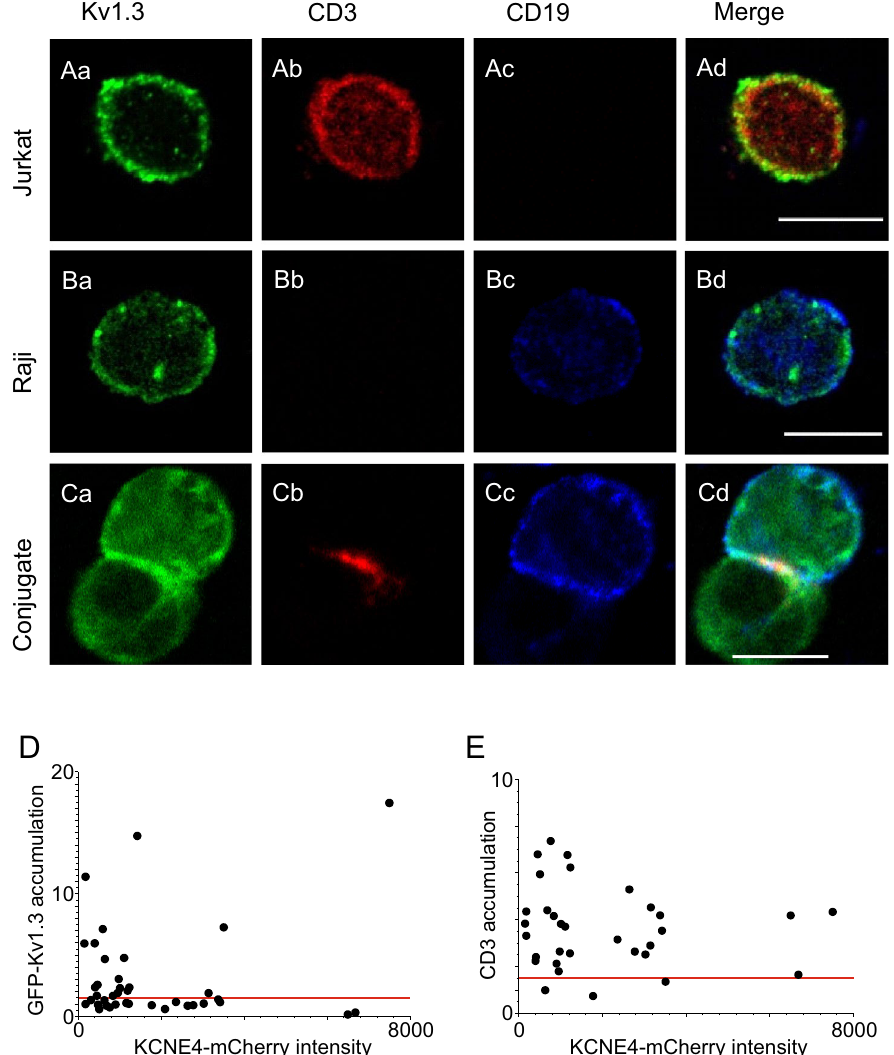
Figure 4. KCNE4 impaired Kv1.3 accumulation in the IS but did not disrupt IS formation. Human Jurkat T lymphocytes and human Raji B lymphocytes were used to generate cell conjugates. ( A – C ) Activated B-cells (10 µg/mL SEE toxin) were cocultured in the absence ( Ba – Bd ) or presence ( Ca – Cd ) of Jurkat cells, and confocal images were obtained. ( Aa – Ad ) Jurkat T-cells in the absence of B cells. Endogenous Kv1.3 (green), CD3 (marker of T-cells, red), and CD19 (marker of B-cells, blue) were detected. ( Ad , Bd , Cd ) merge panels. Note that triple colocalization (white) in Cd localizes Kv1.3 in the IS, as identified by CD3 staining ( Cb ). Bars are 20 µm. ( D ) Accumulation ratio of mGFP-Kv1.3 at the IS vs. KCNE4-mCherry total intensity (n = 40). ( E ) CD3 recruitment into the IS vs. KCNE4 intensity. The horizontal red line represents the threshold level (1.5) for Kv1.3 and CD3 accumulation in the IS. Values greater or less than 1.5 indicated positive or negative accumulation of proteins at the IS,